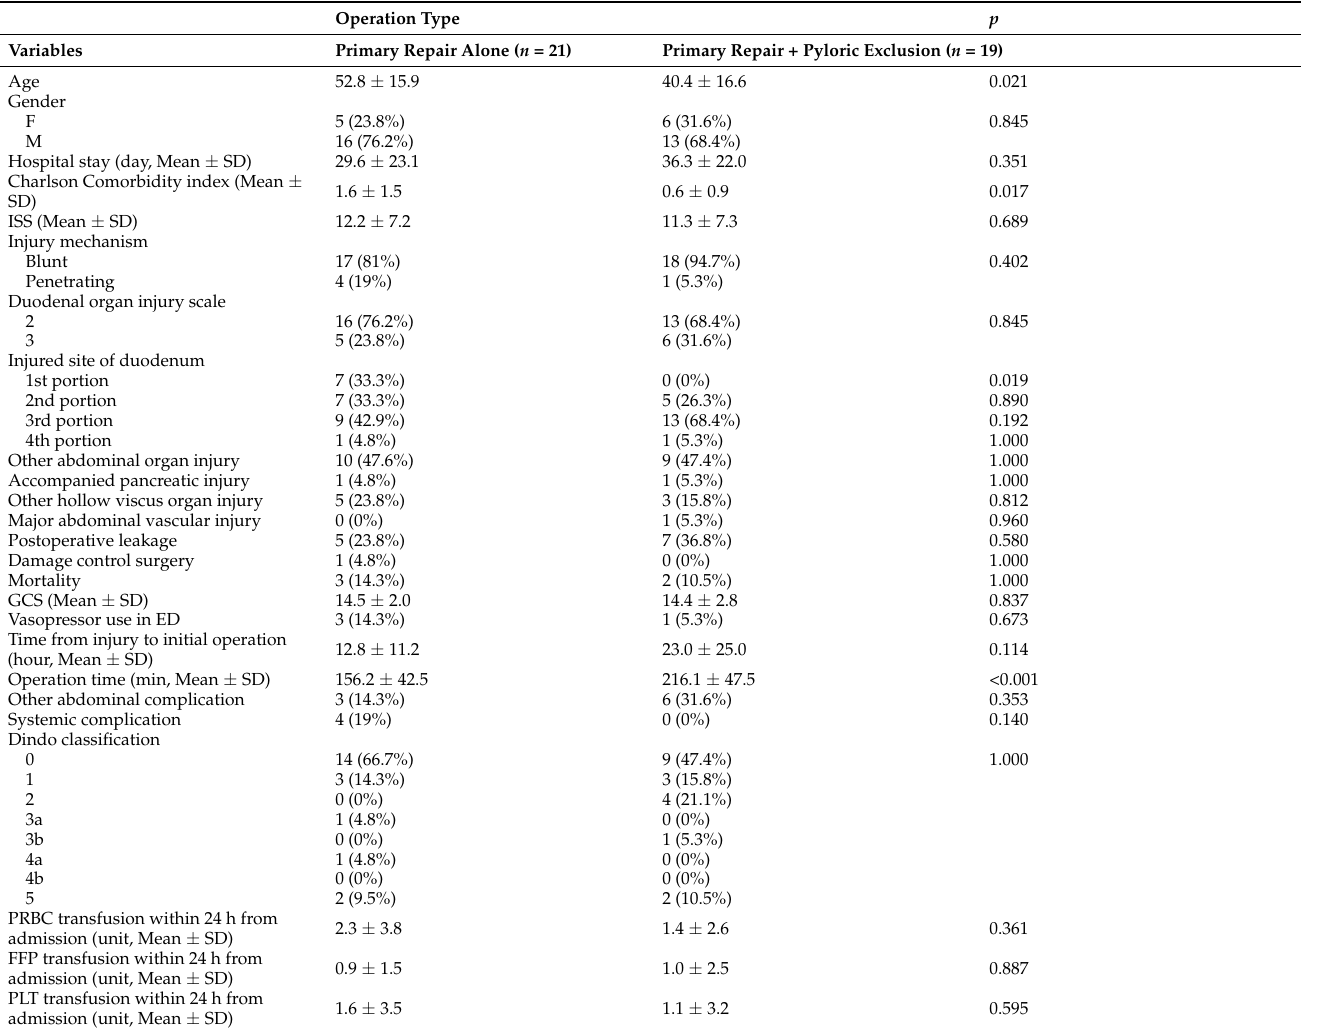
Table 4. Comparison between two types of surgery (primary repair alone vs. primary repair + pyloric